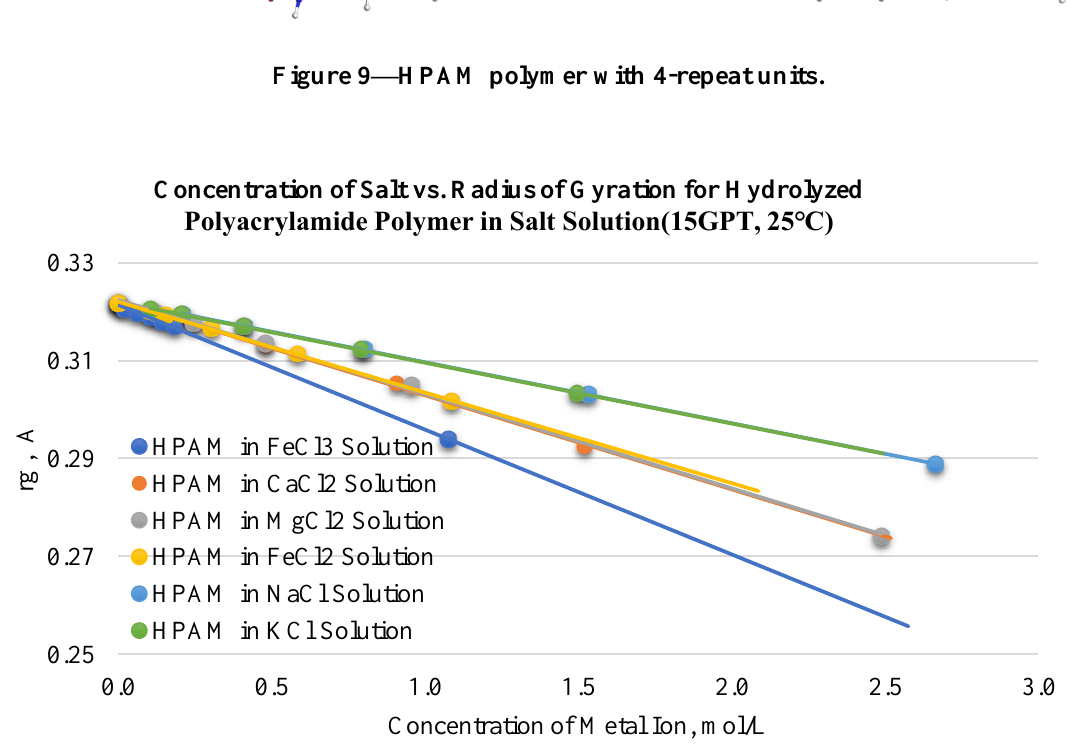
Figure 10—Radius of gyration evolution when HPAM interacts with different metal ions in different